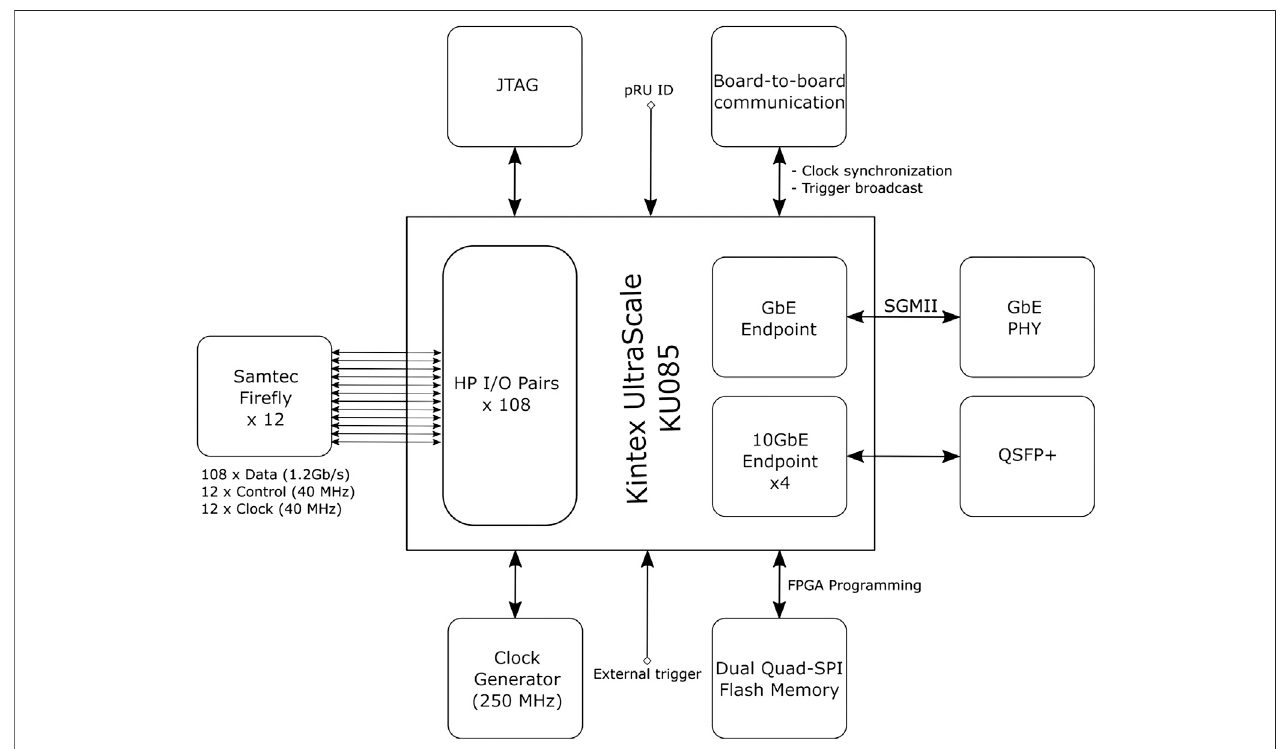
FIGURE 8 | Block diagram of the pCT readout unit